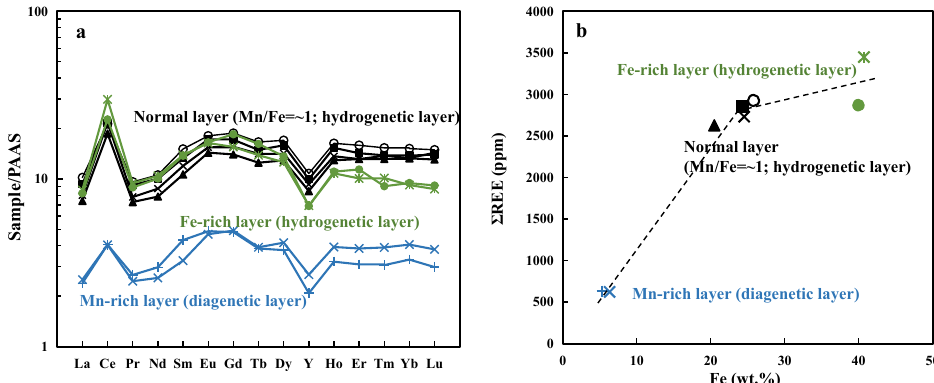
Figure 8. ( a ) PAAS [18] normalized REE + Y of each sublayer (LA-ICP-MS); ( b ) Relationship of Fe with REE (from in- situ LA-ICP-MS analyses).